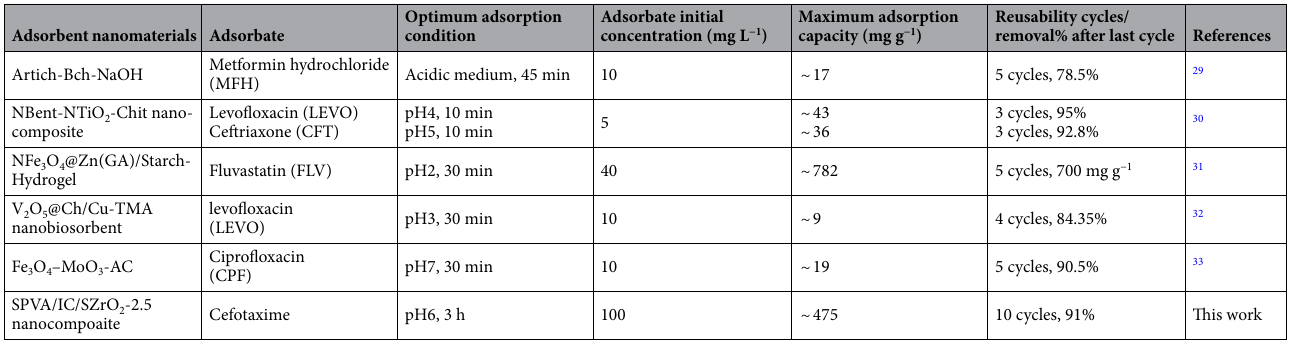
Table 4. A review of the performance of some nanocomposite adsorbent materials used to remove drug from